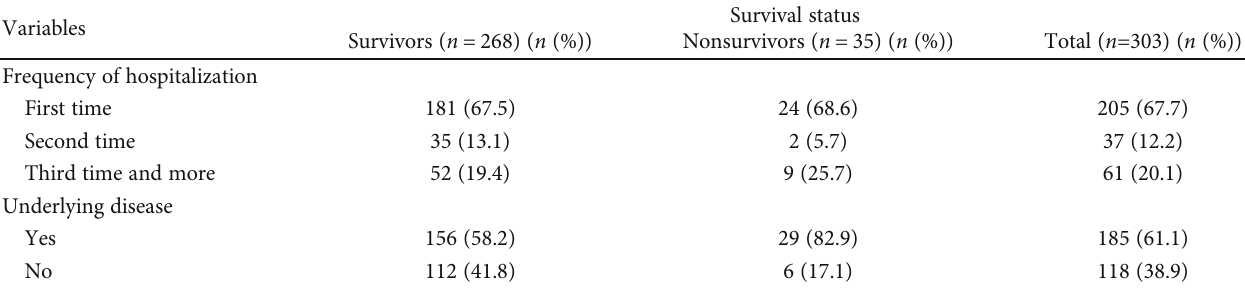
Table 4: Patients ’ survival status based on the frequency of hospitalization and underlying